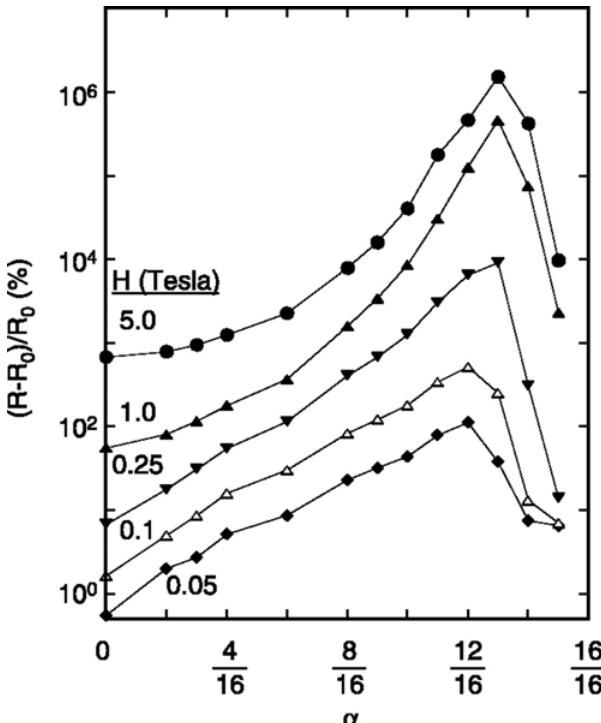
Figure 4. The magnetoresistive (MR) versus filling factor α of an internally shunted vdP disk of InSb and Au at magnetic fields of 0.05, 0.1, 0.25, 1.0, and 5.0 T. Reprinted with permission from [17]. Copyright 2000 American Association for the Advancement of